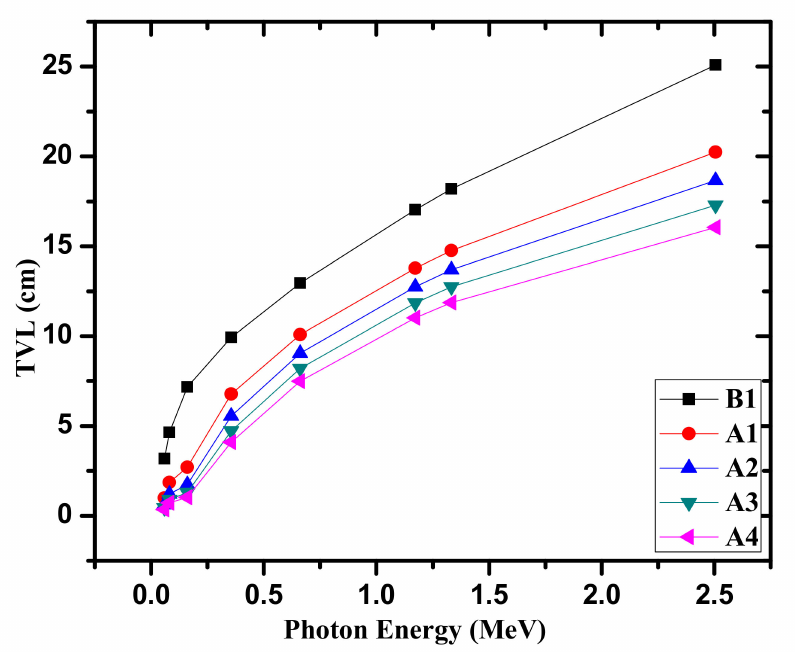
Figure 6. The TVL for the fabricated